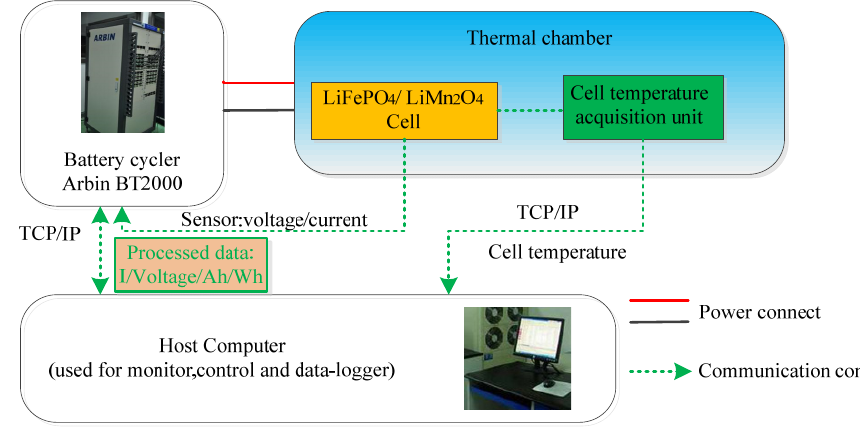
Figure 4. The battery test bench.